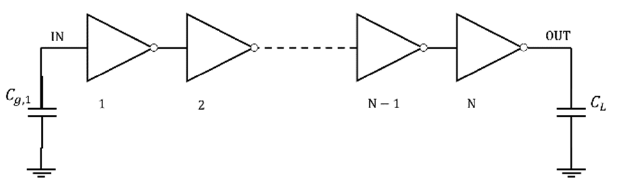
Figure 4. The schematic diagram of the buffer chain.